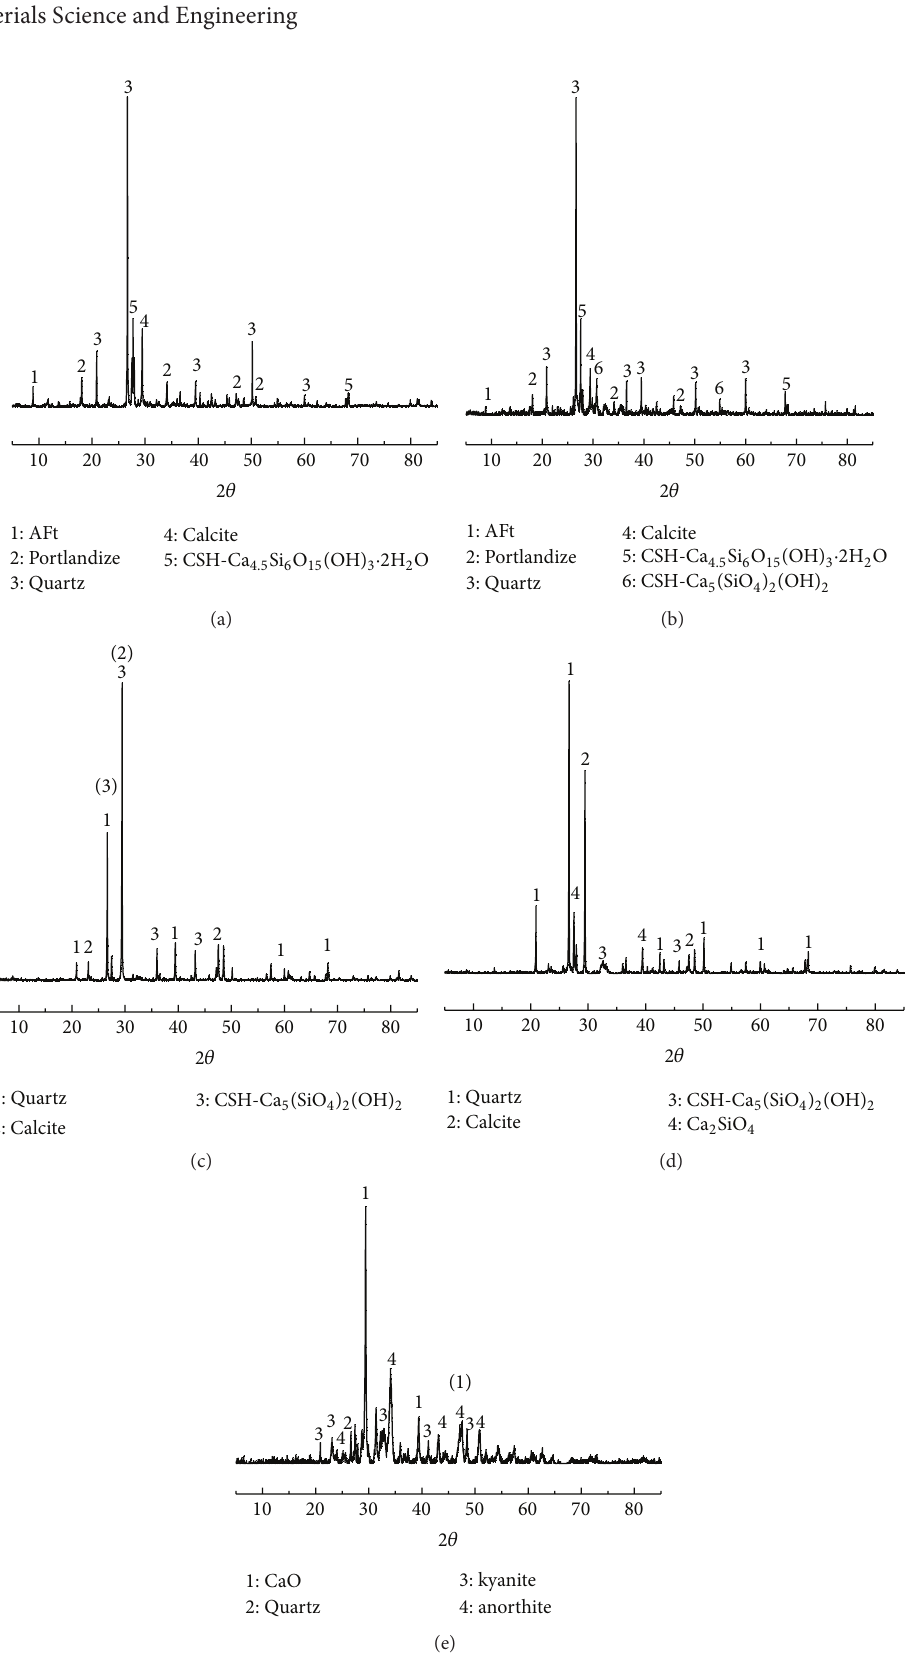
Figure 21: XRD spectrums of CFRC matrix exposed to different temperatures. (a) 20 ∘ C; (b) 300 ∘ C, 4h; (c) 600 ∘ C, 4h; (d) 800 ∘ C, 4 h; (e) 1050 ∘ C, 4